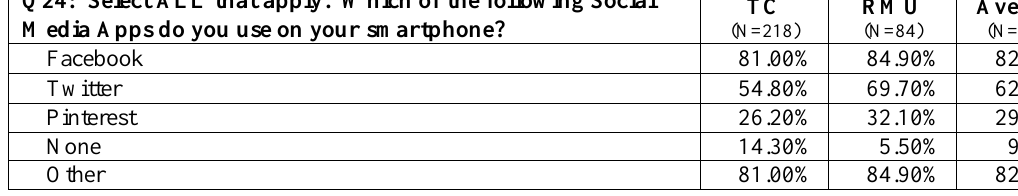
Table 7. RQ7: Primary Social Media